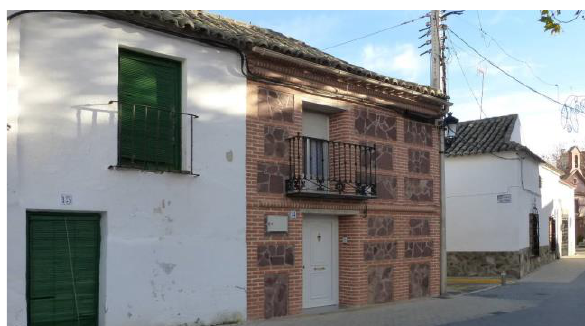
Figure 6. Traditional house in Numancia de la Sagra